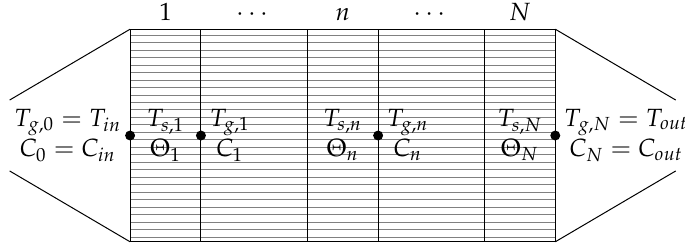
Figure 1. Illustration of the catalyst